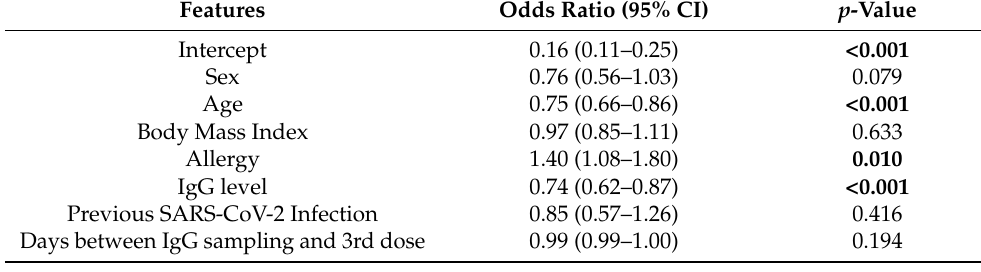
Table 2. Results of multivariate logistic regression for Omicron Infection.